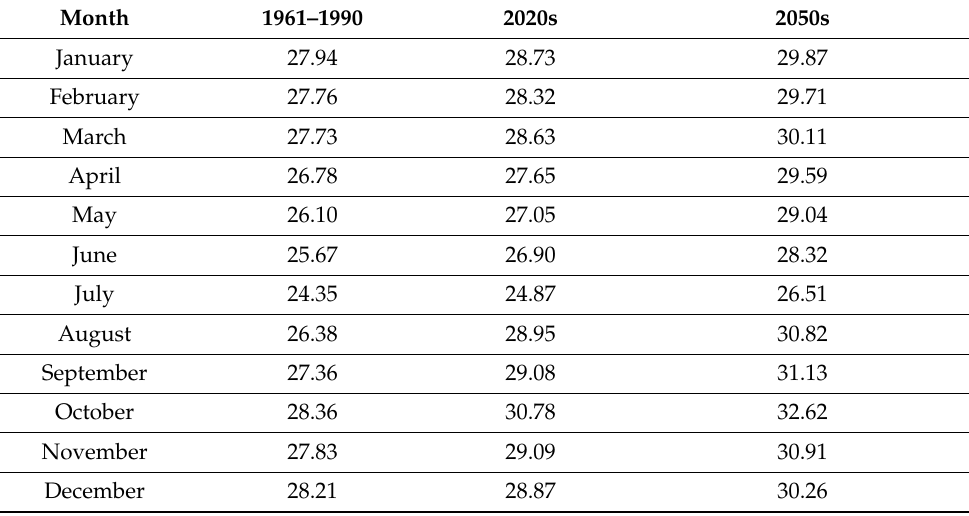
Table 4. Monthly soil temperature for the base scenario (1961–1990) and future estimates